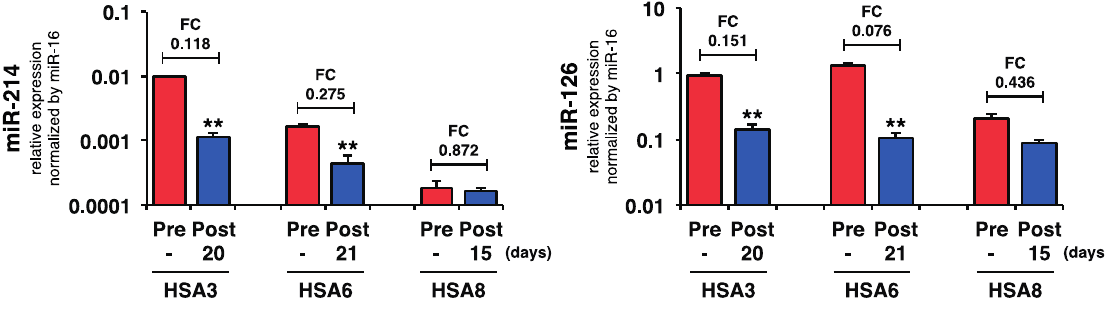
Figure 5. Surgical resection of the primary tumor decreased the levels of plasma miR-214 and miR-126. Surgical resection of primary tumor significantly decreased the levels of both miR-214 and miR-126 in two out of three cases shown. (Paired two-tailed t -test; ** p < 0.01 for comparisons with the levels of pre-operation